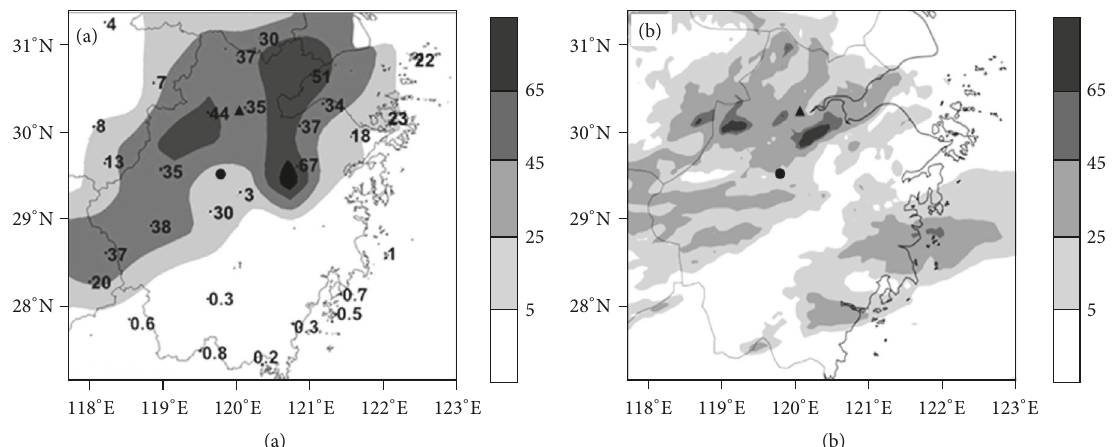
Figure 2: Six-hour cumulative precipitation in Zhejiang at 20:00 CST on November 9; (a) observed and (b) simulated (unit: mm). The black dot represents the Pujiang area and the black triangle represents the Hangzhou